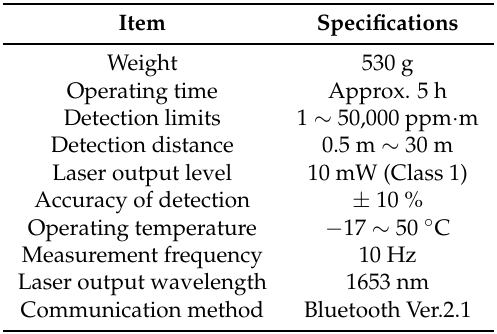
Table 4. Main Specifications of Laser Methane mini-G.